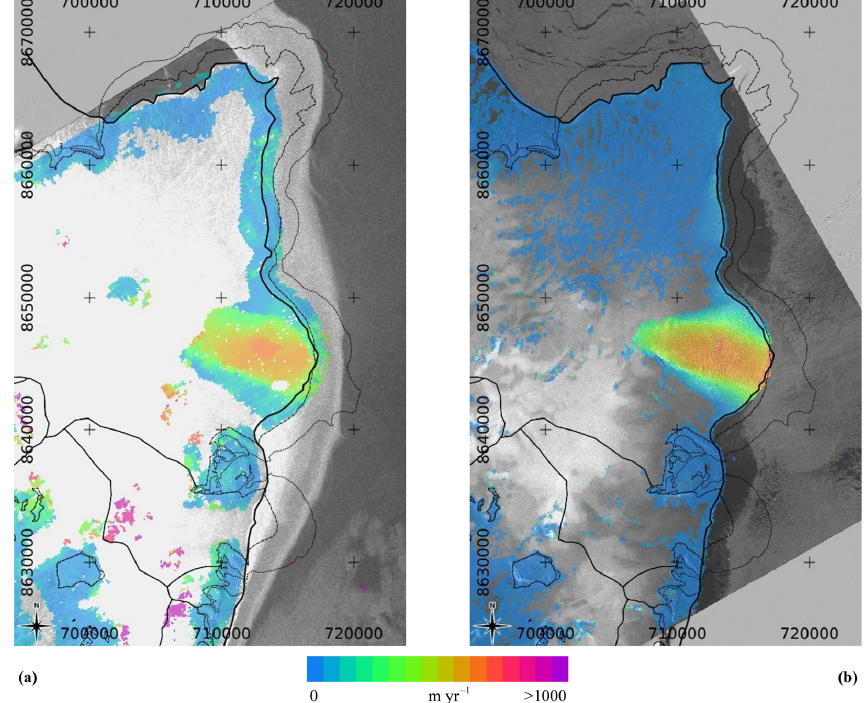
Figure 8. Ice surface velocity maps from (a) Sentinel-1 data of 4 March 2016 and 16 March 2016 and (b) Radarsat-2 UWS data of 28 February and 23 March 2016. Image background is a backscattering intensity image of the master scene used for offset tracking. The coastal outline in 2015 (continuous line) is shown along with glaciers inventories of 1971 (dotted line) and 2006–2007 (RGI 5.0, dashed line).